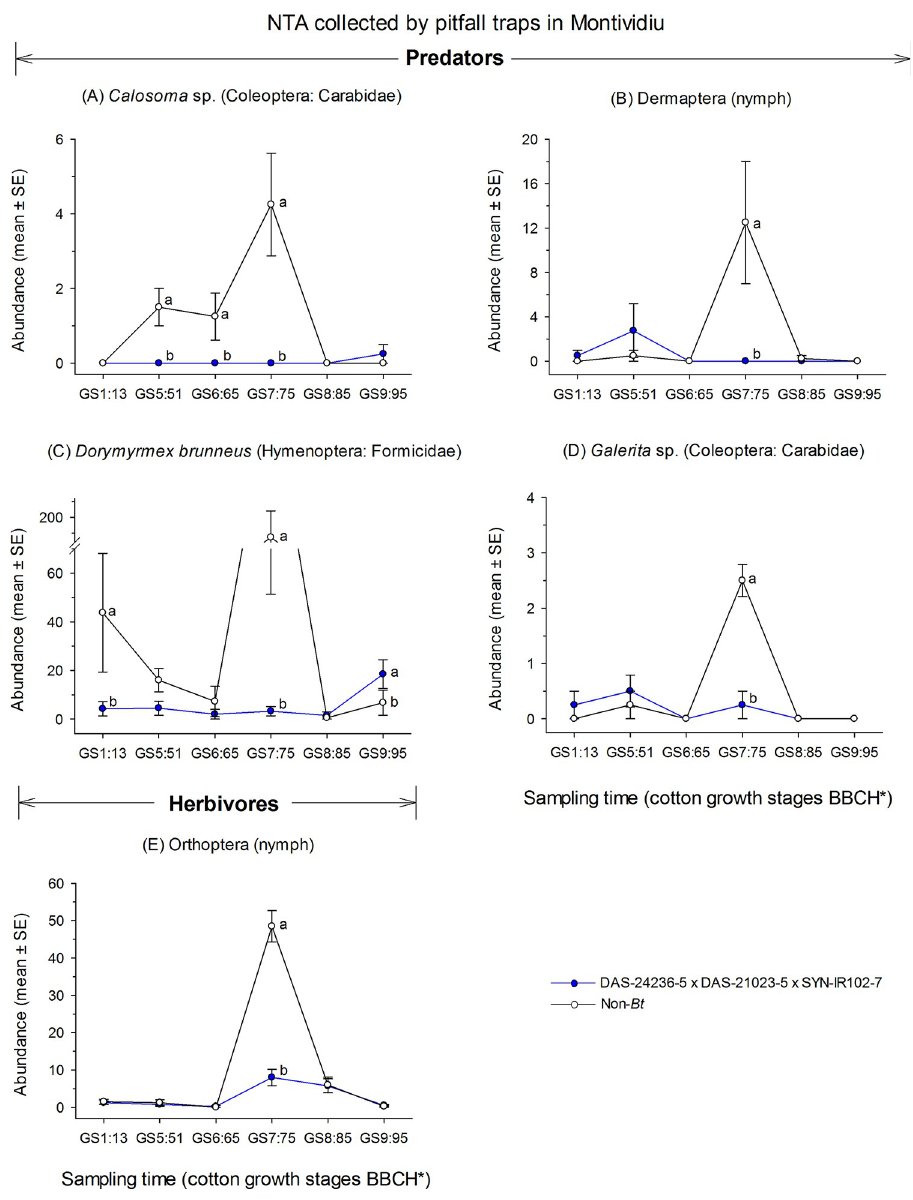
Fig 10. Abundance of ground-dwelling arthropods collected via pitfall trapping in a cotton trial at Montividiu (2014/2015 cropping season). Means ( ± SE) within sampling time followed by different letters are significantly different by two-way RM-ANOVA ( α = 0.05). � Phenological growth stages of cotton classified according to Munger et al.